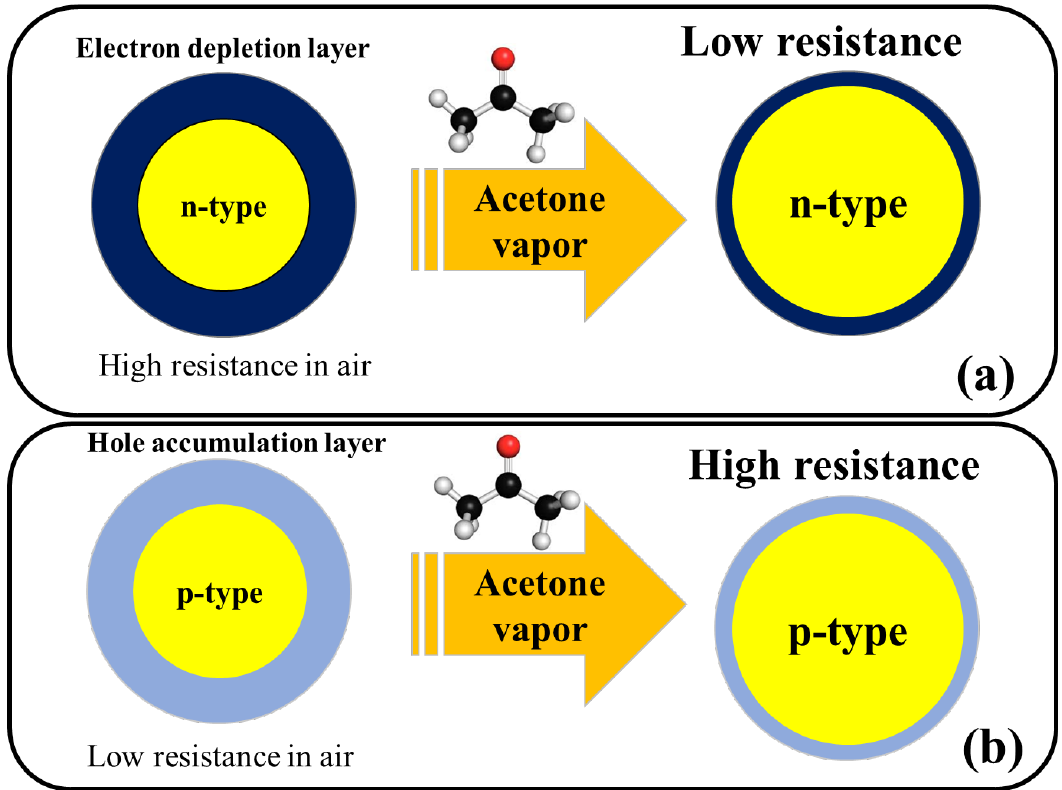
Figure 2. Schematic illustration of acetone sensing mechanism in ( a ) n-type metal oxides and ( b ) p-type metal oxides.